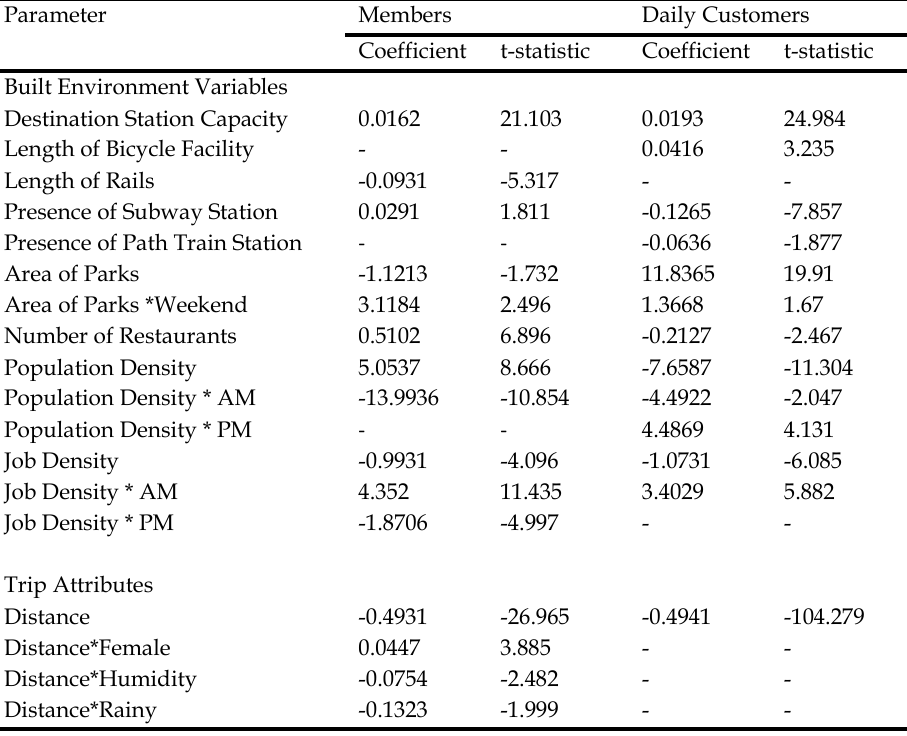
Table 3. Destination Choice Model Estimation